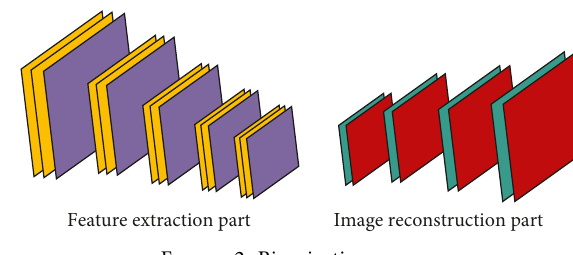
Figure 2: Binarization